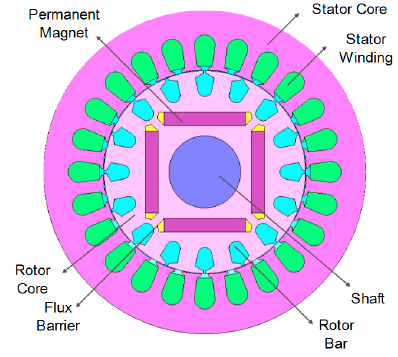
Figure 4. Two-dimensional (2-D) geometry model parts of LSPMS motor. Figure 4. Two ‐ dimensional (2 ‐ D) geometry model parts of LSPMS motor. Figure 4. Two ‐ dimensional (2 ‐ D) geometry model parts of LSPMS motor.